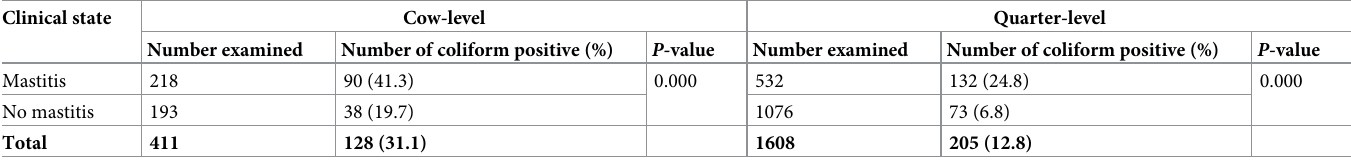
Table 3. Coliform bacterial isolation in mastitis and non-mastitis